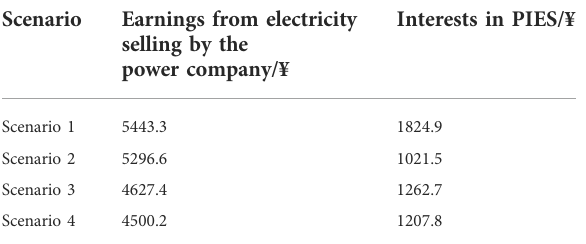
TABLE 2 Income comparison of the integrated energy system of the distribution network and park under different scenarios.